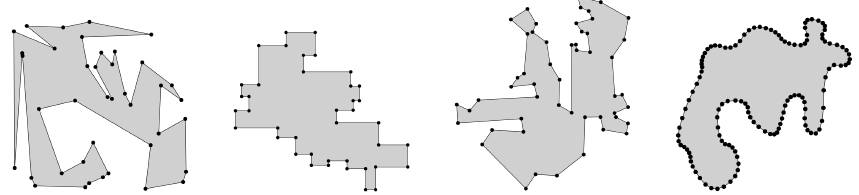
Figure 9. Examples of random polygons from Salzburg Database of Geometric Inputs